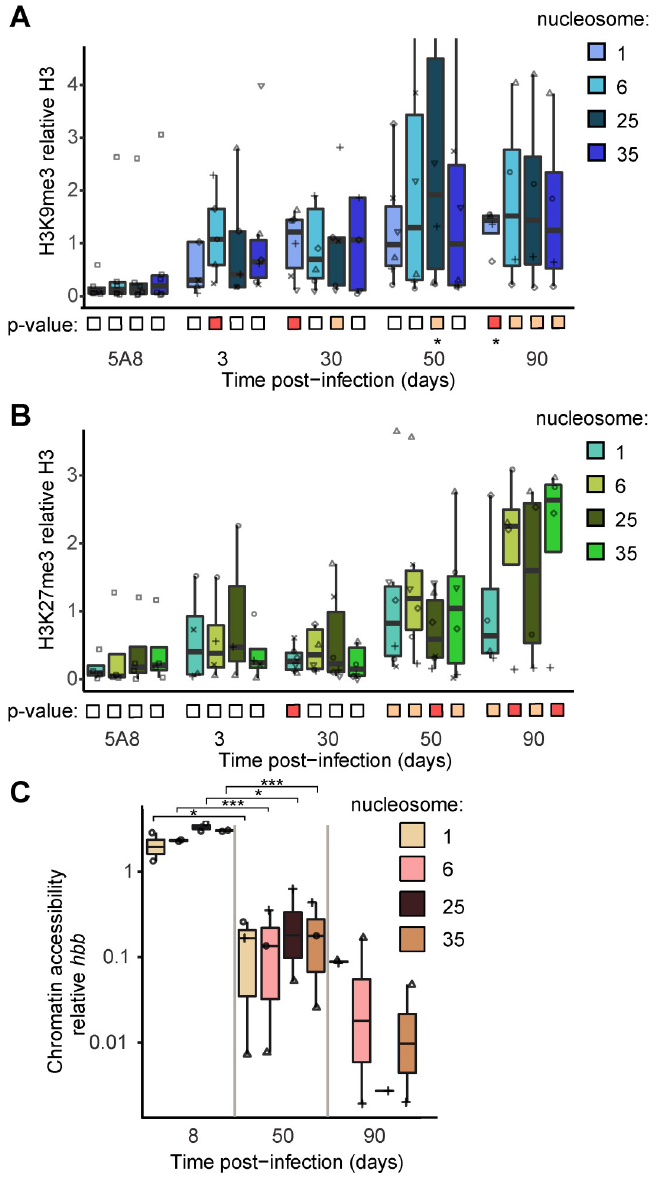
Fig 5. Appearance of heterochromatin and chromatin compaction along HIV-1 proviral chromatin. ( A ) Boxplots for ChIP-qPCR signals for constitutive heterochromatin mark H3K9me3. ( B ) ChIP-qPCR signal for facultative heterochromatin mark H3K27me3. In panels (A, B), for each point the specific ChIP signal is divided by the H3 signal for the same sample. Samples where the unspecific IgG signal is higher than the specific signal are discarded. P-values were calculated: boxes below the x-axis indicate a one-sample t-test (null hypothesis: specific normalized ChIP signal equals zero) orange: p < 0.05, red: p < 0.01, white: p > 0.05, stars indicate significance using a two-sample t-test (null hypothesis: specific ChIP signal equals IgG signal) � p < 0.05, �� p < 0.01. ( C ) qPCR signal revealing chromatin accessibility to nucleases. Data is normalized to the heterochromatin hbb locus of the same sample ( n = 3). � p < 0.05, ��� p < 0.001 calculated by paired